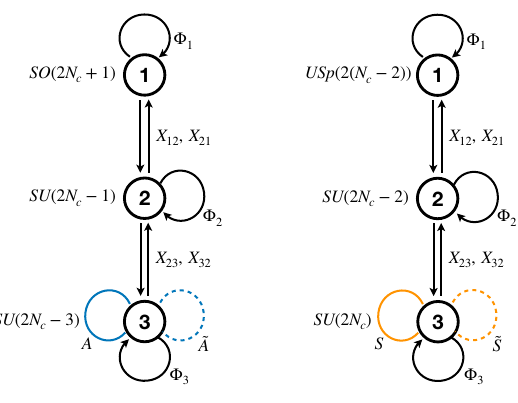
Figure 9 . N = 2 S-dual quiver diagrams with n g = 2